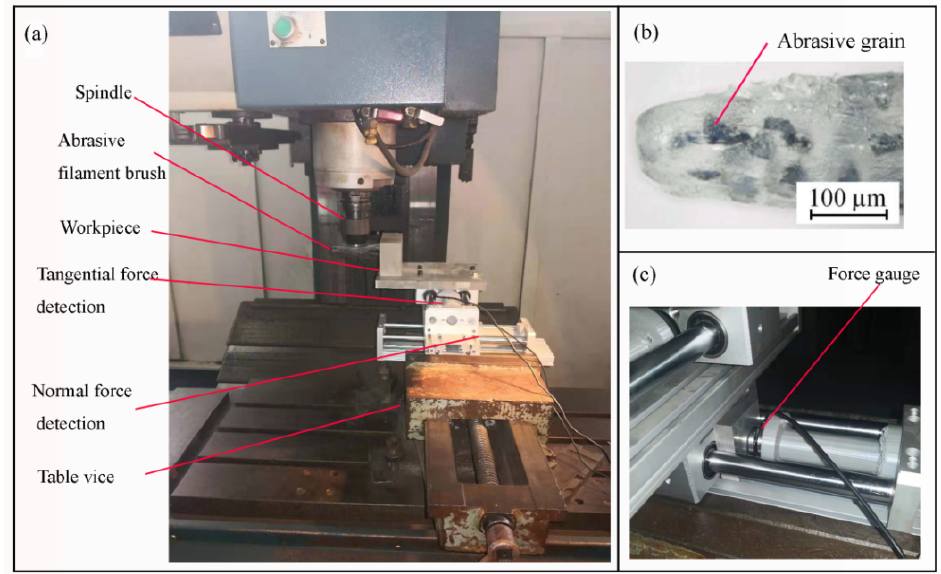
Figure 3. Experimental setup ( a ); abrasive filament; ( b ) and force measure ( c ).